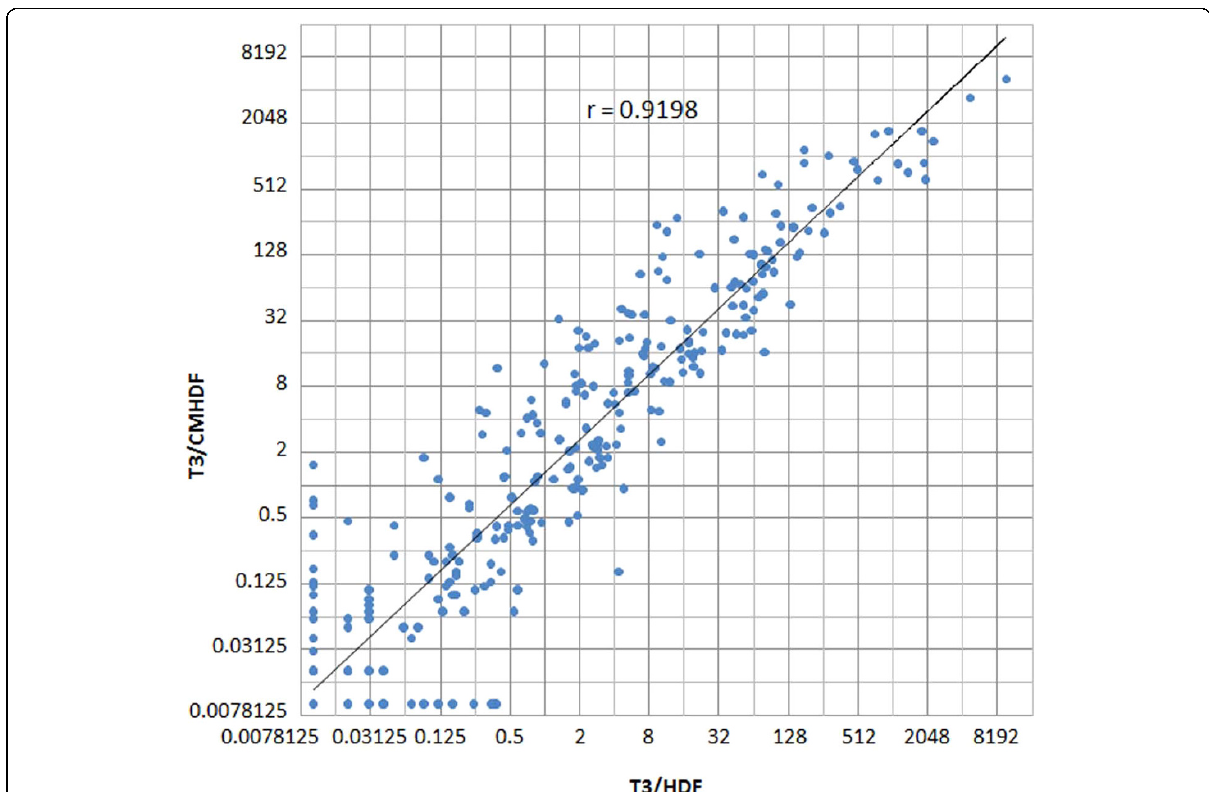
Figure 3 Scatter plot and correlation analysis of miRNAs between T3/HDF and T3/CMHDF cells . The scatter plot was graphed on log2